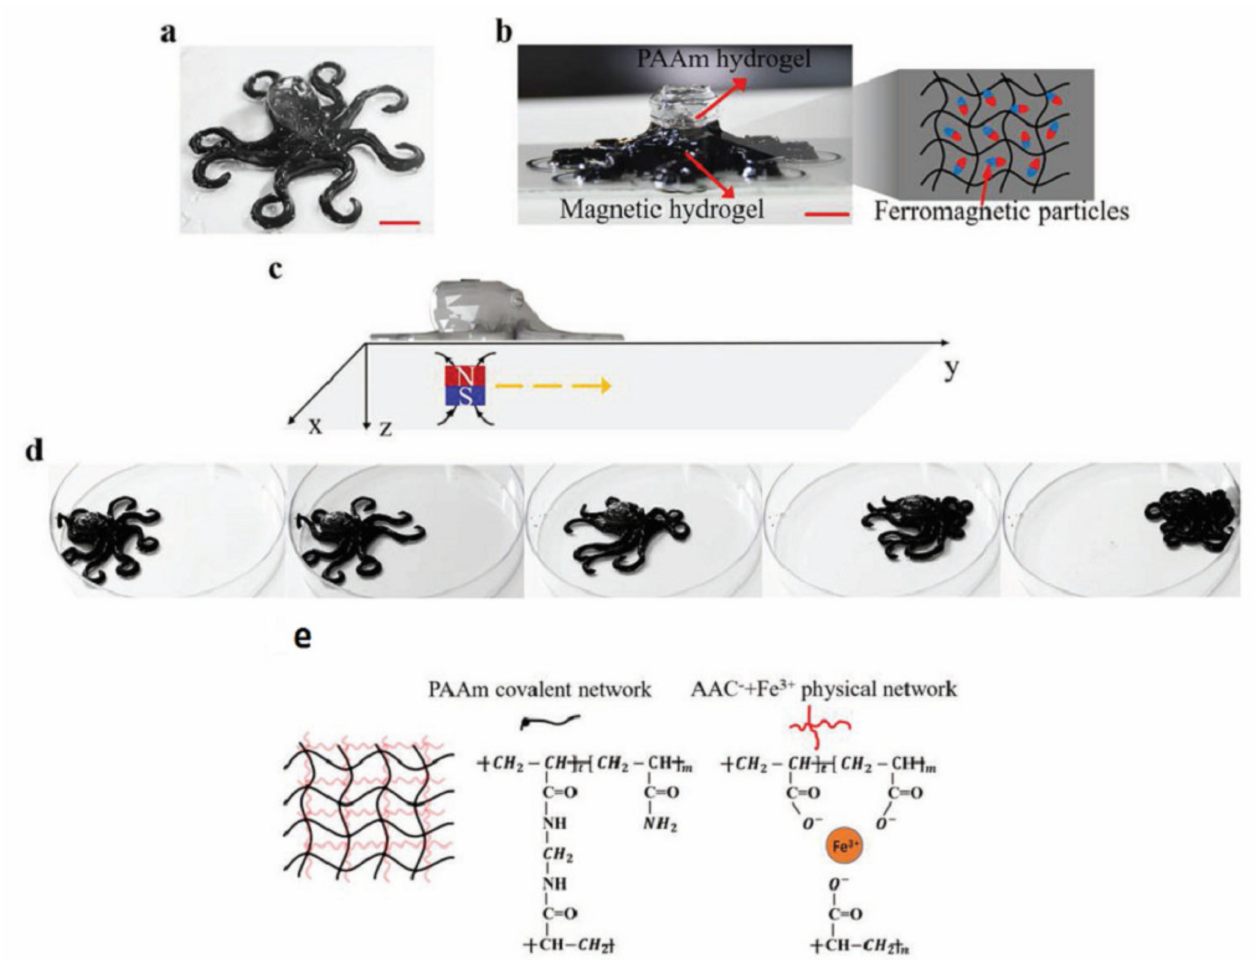
Figure 19. ( a ) Three-dimensional printed soft octopus hydrogels robot. ( b ) Front view of the octopus robot was manufactured in two components: (1) AAM-carbomer ink was used to print a transparent head, (2) AAm-carbomer ink was utilized for the printing of tentacles under the magnet field with ferromagnetic particles (Fe 3 O 4 ). ( c ) Octopus robot scheme moving under a magnetic field driving on the “x-y” plane. ( d ) When the Magnetic Field is designed to travel from left to right, the octopus robot accomplished forward movement. ( e ) Schematic of the tough hydrogel. Scale bars, 1 mm. Copyright 2019 John Wiley@Sons. Reprinted with permission from ref.